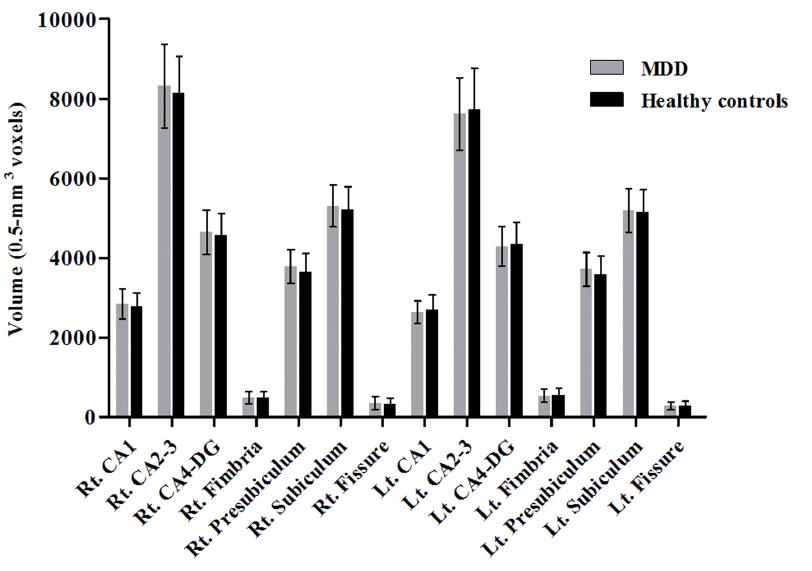
Figure 2. Comparison of hippocampal subfield volumes between patients with major depressive disorder and healthy controls, mean (SD).